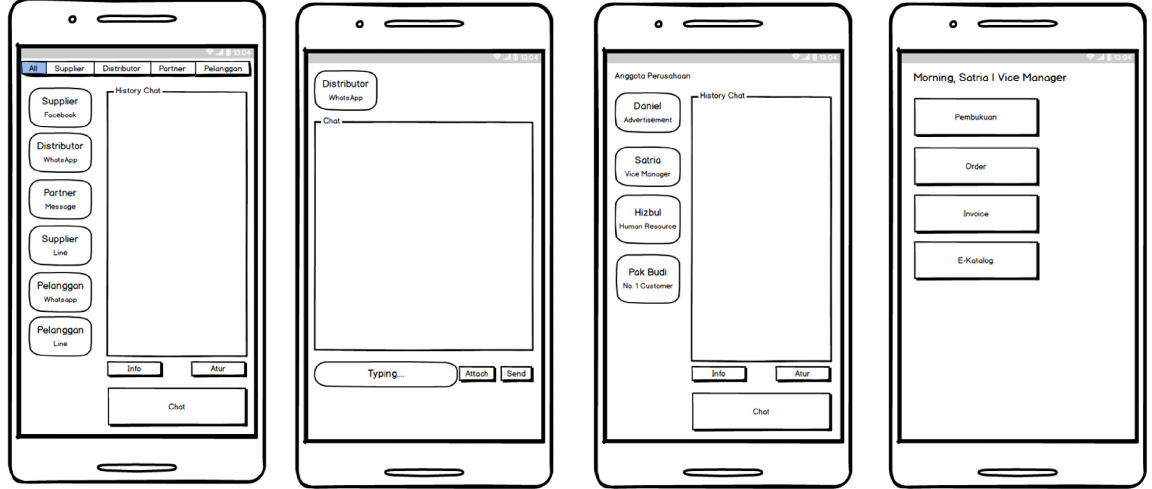
Figure 1. Design of Example view in Communication